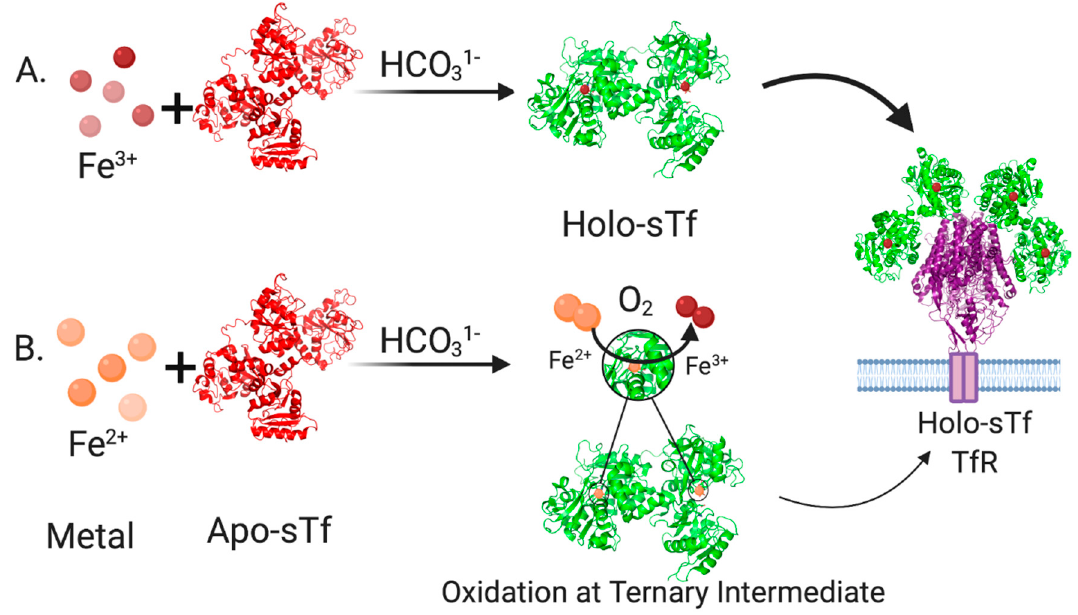
Figure 2. Pathways for sTf binding of Fe forming the Holo-sTf complex that is recognized by the transferrin receptor 1 (TfR). ( A ). In the most common pathway, Fe(III) released into blood is immediately bound by sTf in synergism with bicarbonate. ( B ). In a less common pathway, Fe(II) leached into blood is bound by sTf in synergism with bicarbonate. STf can operate as a ferroxidase and oxidize Fe(II) to Fe(III). Created with BioRender.com.